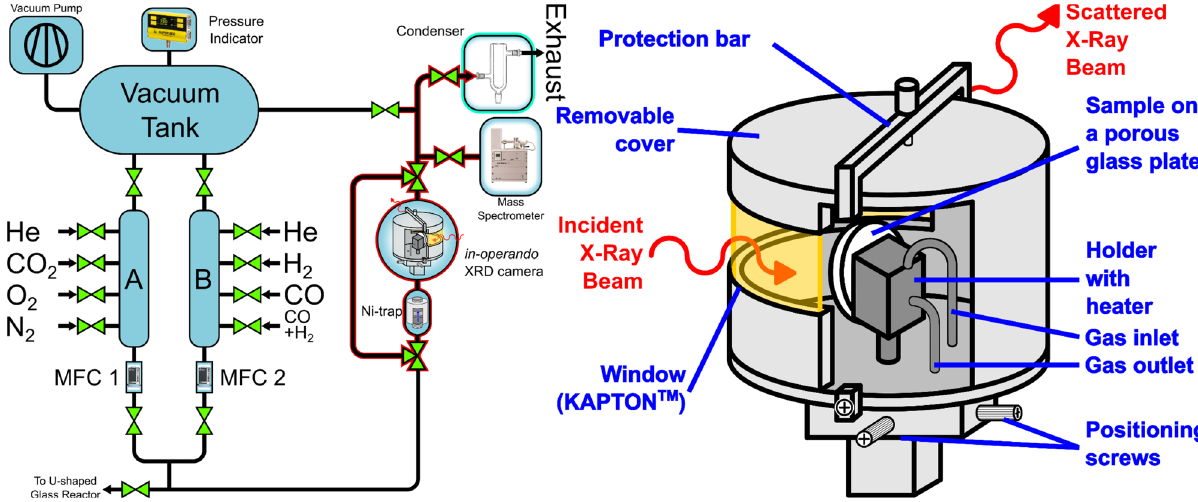
Figure 1. Scheme of experimental setup and of PXRD environmental chamber. For the detailed description refer to Electronic Supplementary